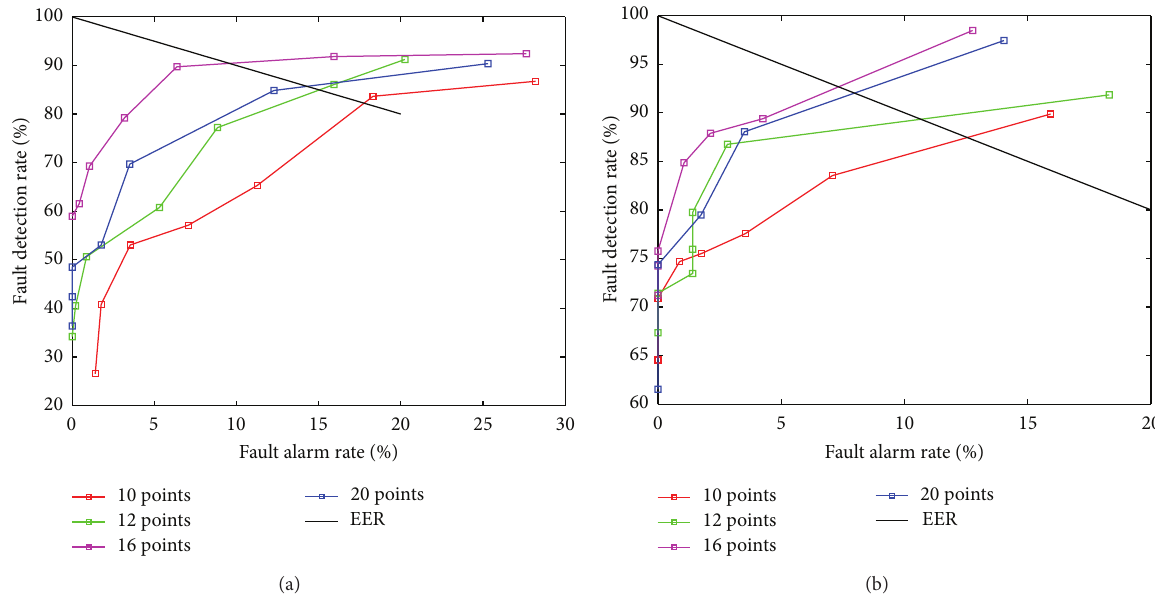
Figure 2: The relationship between the fault diagnosis performance and the length of the MTS pieces. The points on FAR-FDR curves record the experimental results with different 𝑘 in KNN algorithm. Among these points, the one which is the closest to the EER curve represents the fault diagnosis performance. The experimental results reveal that the proposed method will have the best performance when the length of the MTS pieces is set as 16. (a) The results on IDV(11). (b) The results on IDV(21).